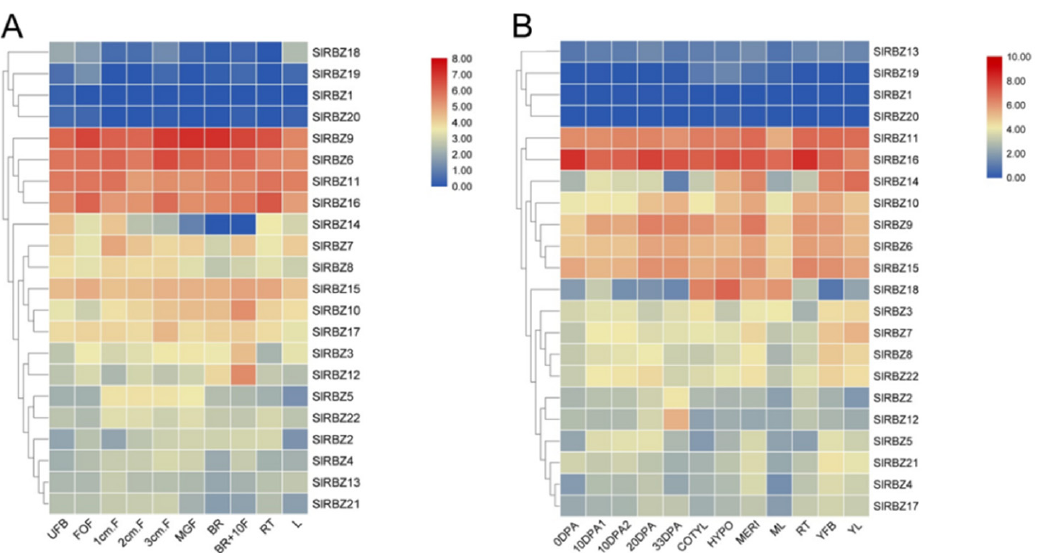
Figure 5. Heatmap of the expression profiles of SlRBZ genes in the cultivated tomato cultivar Heniz 1706 ( A ) and the wild species S. pimpinellifolium LA1589. ( B ) Fully opened flowers (FOF), unopened flower buds (UFB), 1 cm fruits (1cm.F), 2 cm fruits (2cm.F), 3 cm fruits (3cm.F), mature green fruits (MGF), breaker fruits (BR), breaker+10 fruits (BR+10F), roots (RT), leaves (L), days post-anthesis fruit (DPA), cotyledons (COTYL), hypocotyl (HYPO), vegetative meristems (MERI), mature leaves (ML), young flower buds (YFB), young leaves (YL). Dark red indicates higher expression levels, and dark blue indicates lower expression levels. Genes with similar expression profiles across various arrays are grouped on the left based on a hierarchical clustering method.